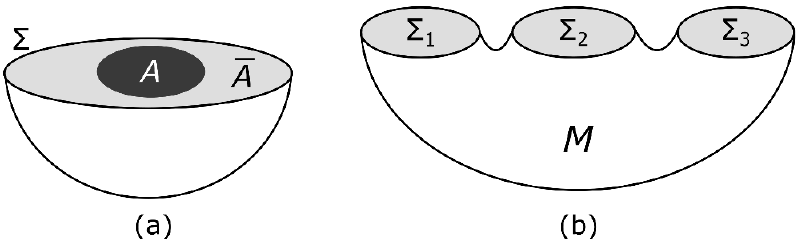
Figure 1 . Figure (a) shows a manifold having a single boundary Σ which is partitioned into a sub-region A and its complement ¯ A . Figure (b) shows the manifold M whose boundary has three disconnected components, i.e. Σ